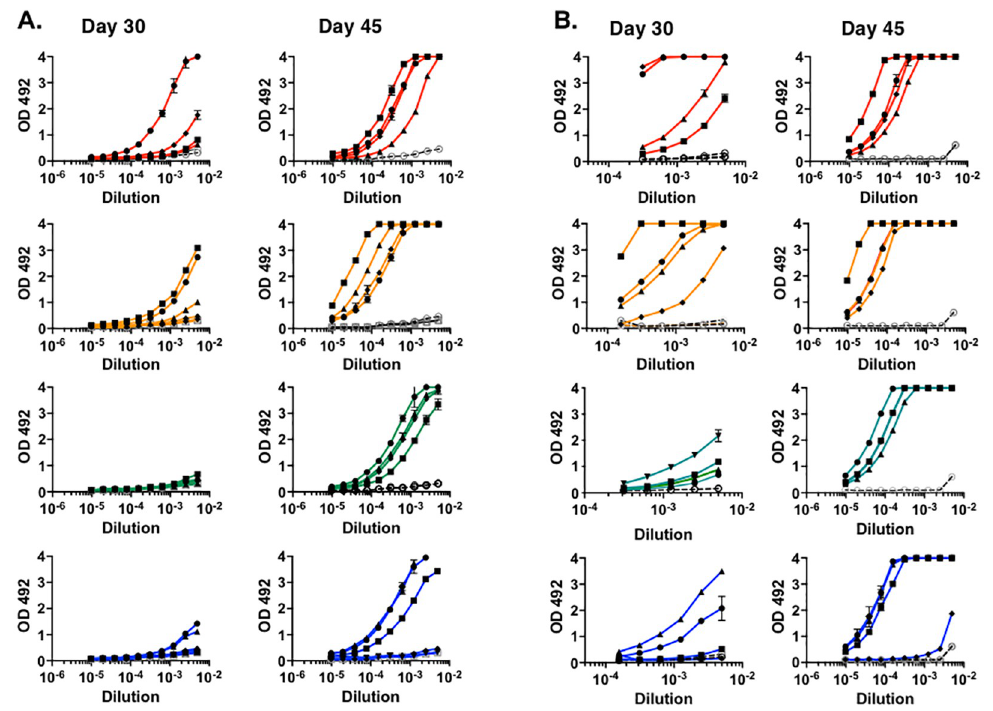
Fig 2. ELISA binding of immune sera of mice after prime-boost. Binding to RBD ( A ) and Spike protein ( B ) of sera at the timepoints indicated. Closed symbols refer to individual mice. Open symbols refer to binding of pre-immune sera. Day 30 statistical significance analysis. (RBD): group 1 vs. 4, p = 0.086; group 2 vs. 4, p = 0.054; group 3 vs. 4,—value; group 1 vs 3, p = 0.008; group 2 vs 3, p = 0.003. (Spike) group 1 vs. 4, p = 0.003; group 2 vs. 4, p = 0.009; group 3 vs. 4, p = 0.532; group 1 vs 3, p = 6.4E-06; group 2 vs 3, p = 1.69E-07. Results from one experiment representative of three independent runs each performed at different times. Sera tested in duplicate. Color scheme: red = group 1; orange = group 2; green = group 3; blue = group